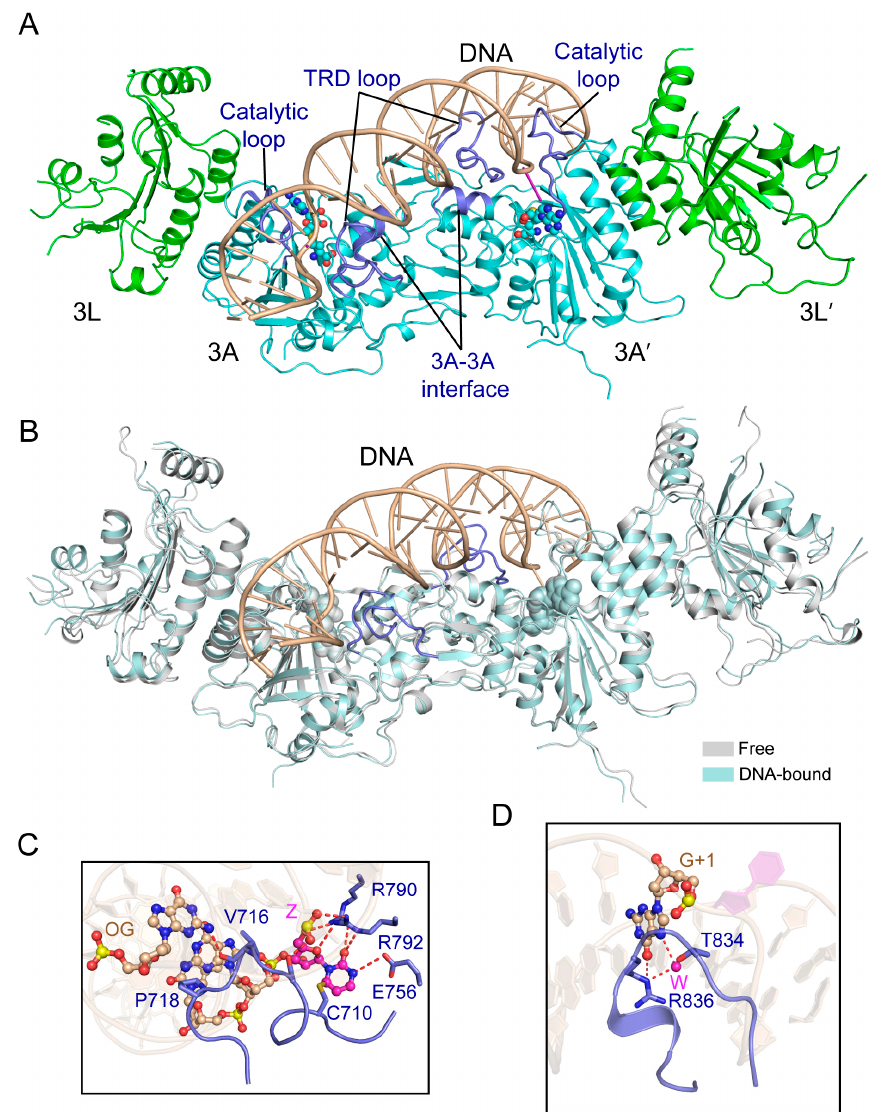
Figure 6. Structural analysis of the productive complex of the DNMT3A-DNMT3L tetramer with CpG DNA. ( A ) Structural overview of the DNMT3A-DNMT3L tetramer covalently bound to a 25-mer DNA duplex containing two CpG/ZpG sites (Z: Zebularine) (PDB 5YX2). The flipped-out zebularines are colored in purple. ( B ) Structural overlap between the DNA-bound and free DNMT3A-DNMT3L tetramer (PDB 2QRV). The TRD loops, which undergo disorder-to-order transition upon DNA binding, are colored in blue. ( C ) The DNA interactions involving the catalytic loop and other catalytic residues. (OG: Orphan guanine). The hydrogen bonding interactions are depicted as dashed lines. ( D ) Residues T834 and R836 from the TRD loop (blue) engage in base-specific recognition of the CpG site. The water molecules are shown as purple spheres.